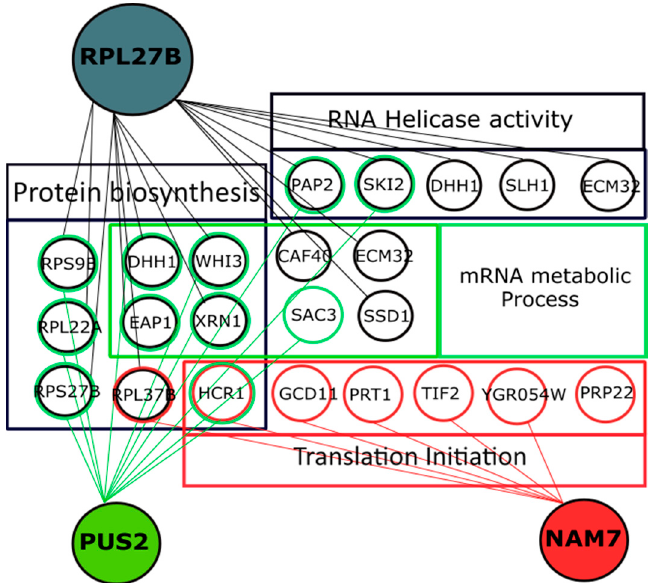
Figure 6. Negative genetic interactions (nGIs) for NAM7 , PUS2 , and RPL27B . Our data shows a cluster of interactors involved in protein biosynthesis pathway for NAM7 ( p = 1.6 × 10 − 7 ), PUS2 ( p = 4 × 10 − 8 ), and RPL27B ( p = 1.2 × 10 − 5 ). PAP2 , SKI2 , RPS9B , RPL37B , RPS27B , RPL22A , DHH1 , EAP1 , WHI3 , HCR1 , and XRN1 are mutual hits shared between two target genes. Circles represent genes, lines represent nGIs identified in this study.